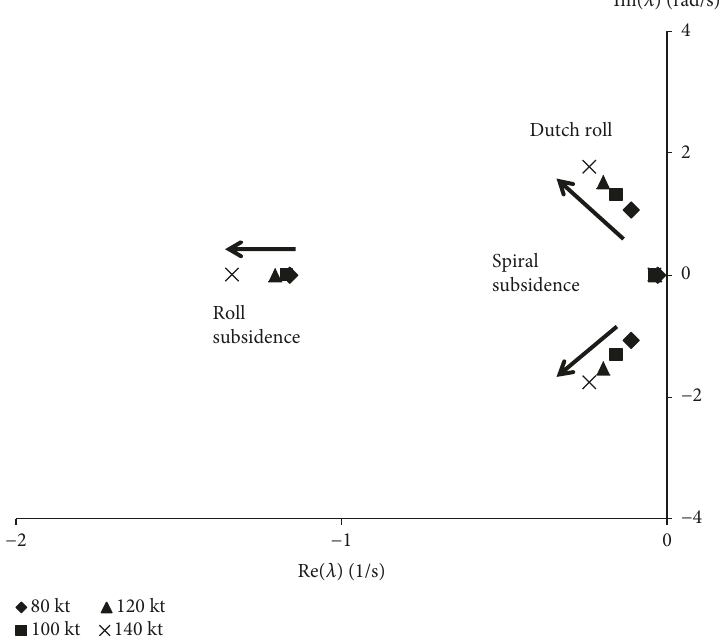
Figure 19: Lateral eigenvalue movement in nacelle 60deg.